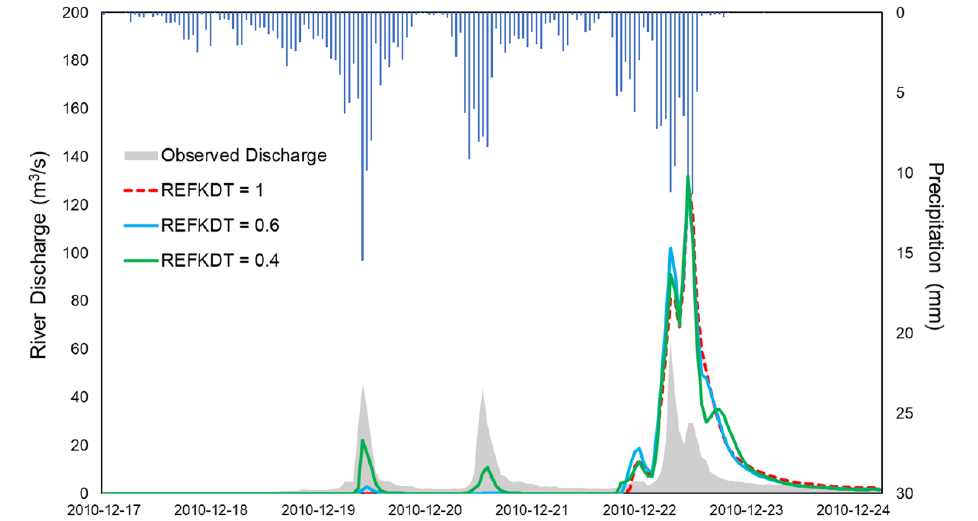
Figure 4. Simulated hydrographs at Arroyo Seco with sensitivity tests of REFKDT.